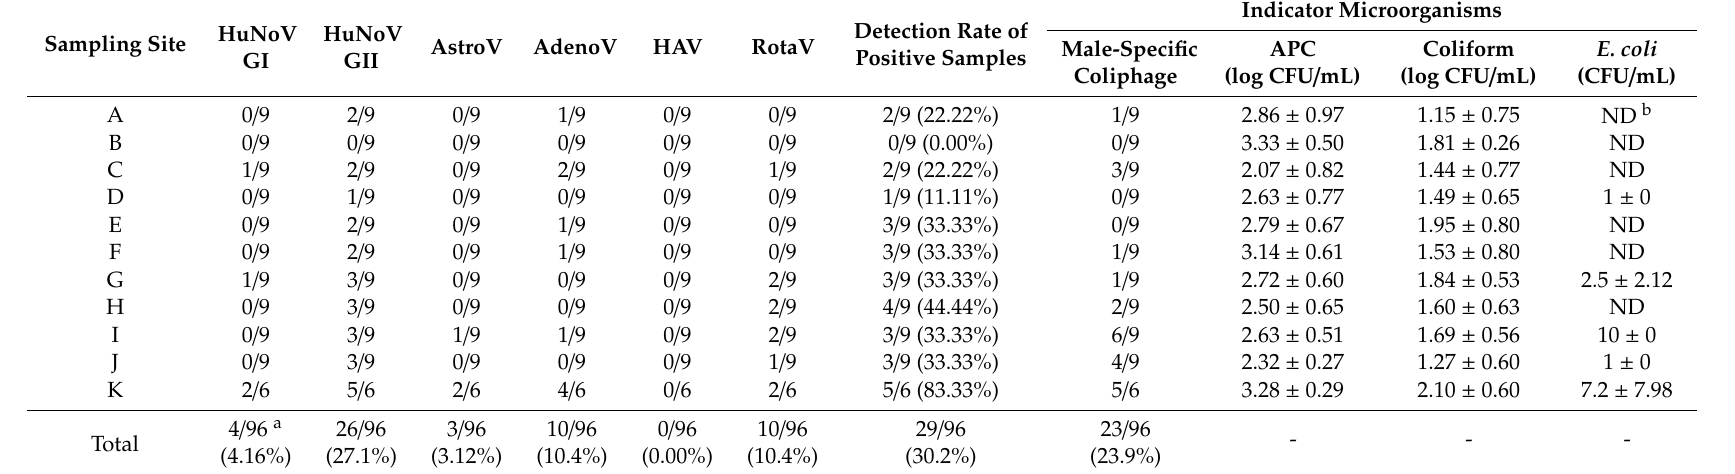
Table 3. Prevalence of foodborne viruses and indicator microorganisms in the ten reservoirs and a